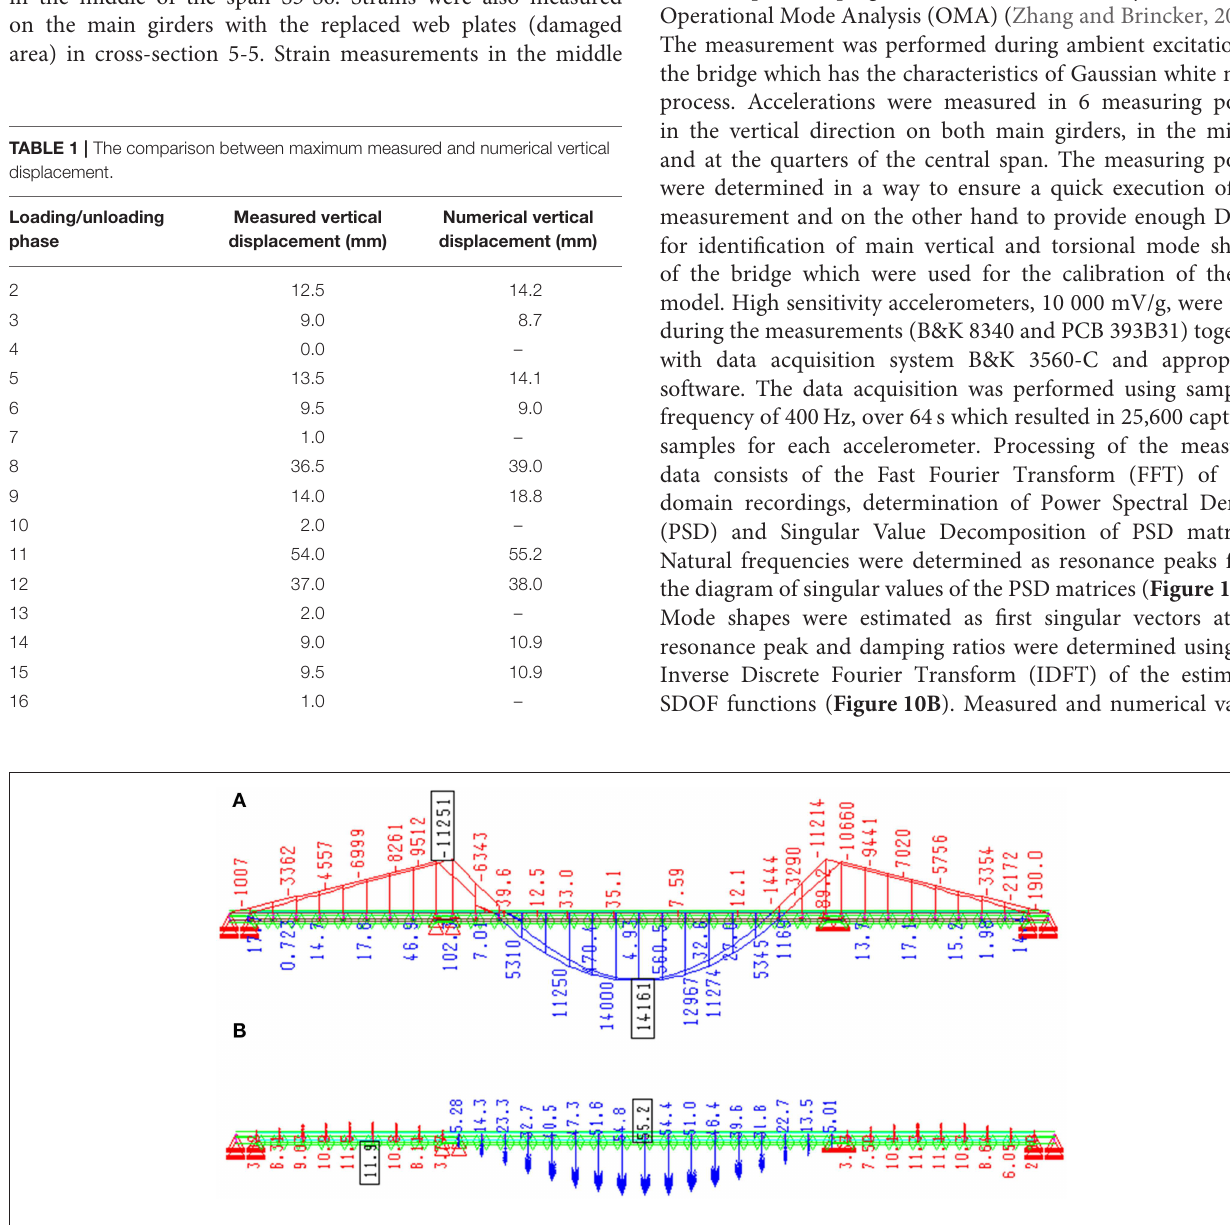
Frontiers in Built Environment |